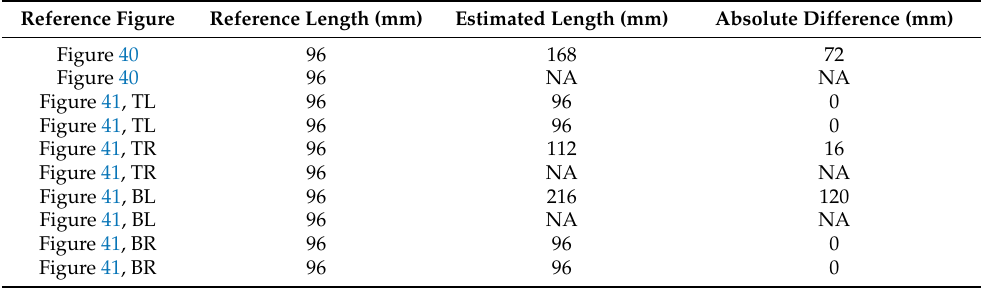
Figure 40. Graphical representation of test case results referred to the quadruple of loads type applied ( left ), and a magnification of the area of interest ( right ). The figure is not to scale. Table 7. Systematic comparison of the reported predictions (Figures 40 and 41): damage length. TL = top left; TR = top right; BL = bottom left; BR = bottom